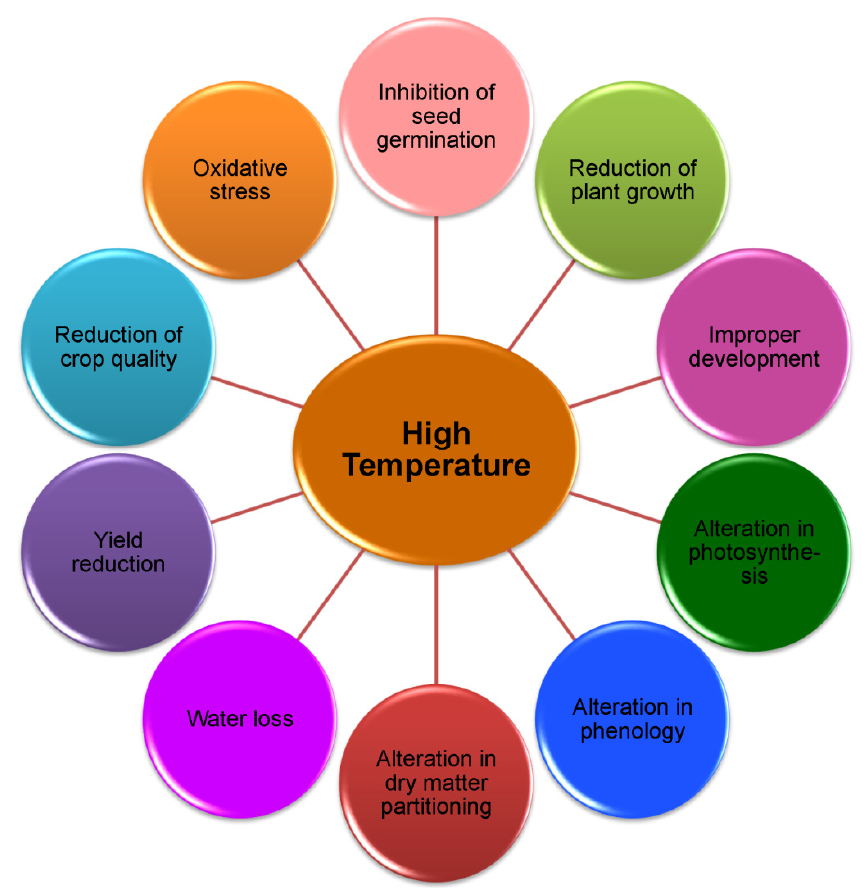
Figure 1. Major effects of high temperature on